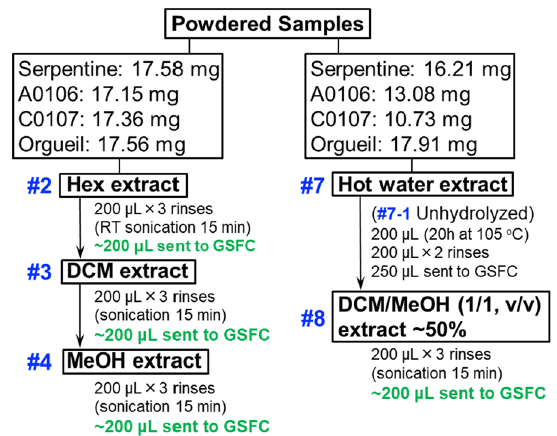
Fig. 1 Extraction flow chart for the untargeted analyses of organic